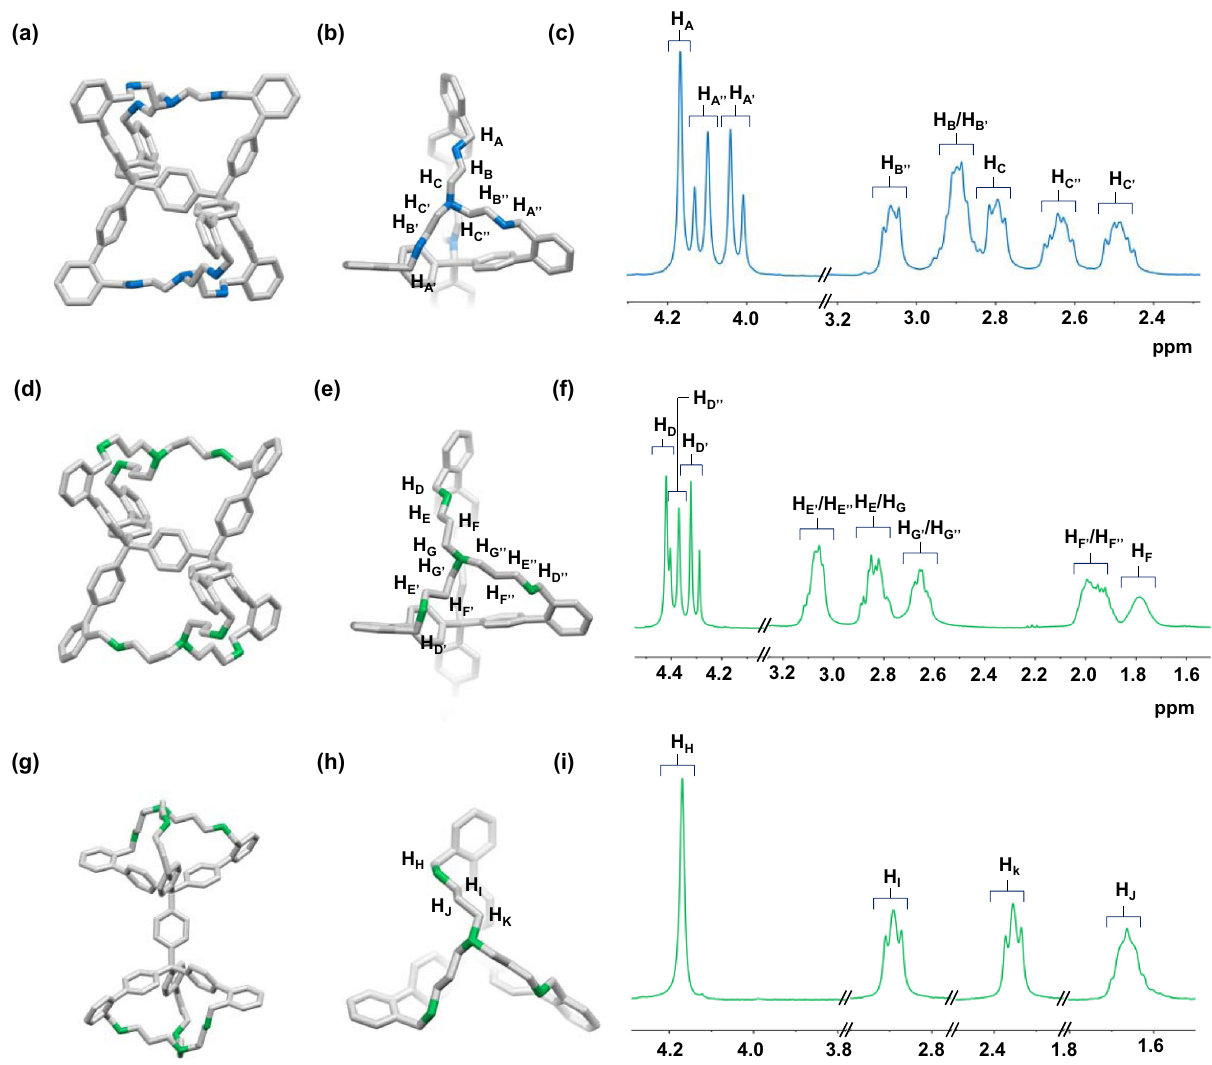
Fig. 4 Molecular structures of three diphanes determined by SC-XRD and 1 H NMR spectroscopy. Side views ( a , d , g ), truncated top views ( b , e , h ), and their corresponding partial 1 H NMR spectra ( c , f , i ) of endo -[1,2,4]diphane (in blue and gray), endo -[1,2,5]diphane (in green and gray) and exo -[1,2,5] diphane (in green and gray), respectively. Hydrogen atoms and solvent molecules are omitted for clarity. Carbon atoms are labeled in gray, and nitrogen in blue and green to distinguish the shorter and longer fl exible chains,